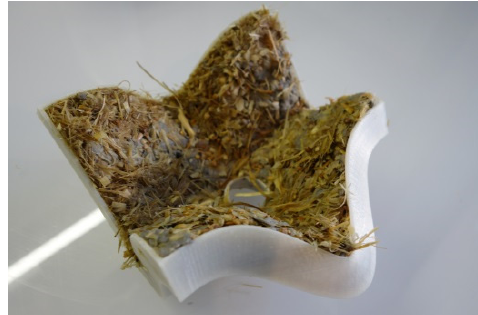
Figure 12. Mycelium material grown in hard plastic shell.